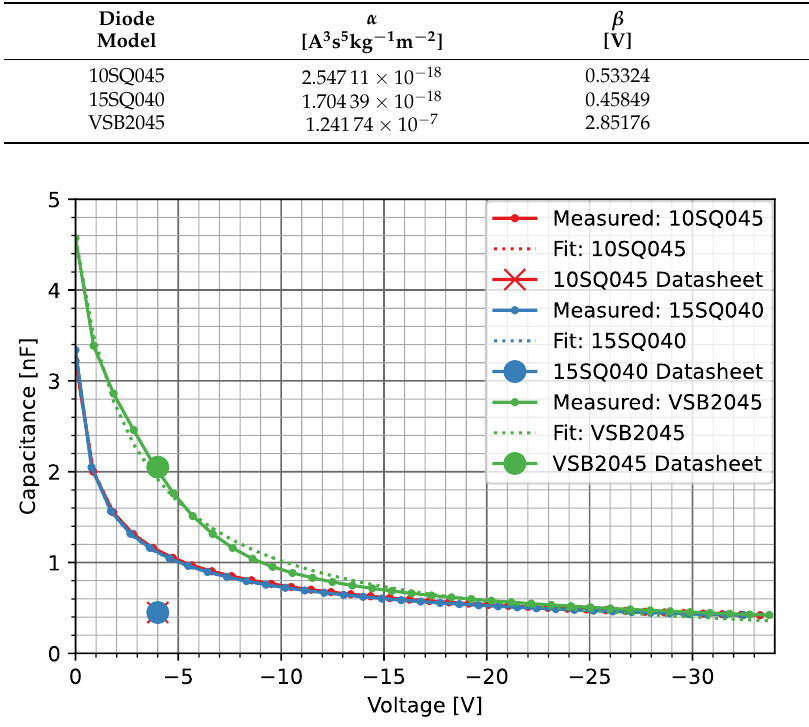
Table 10. Capacitance modelling parameters for the three diodes.